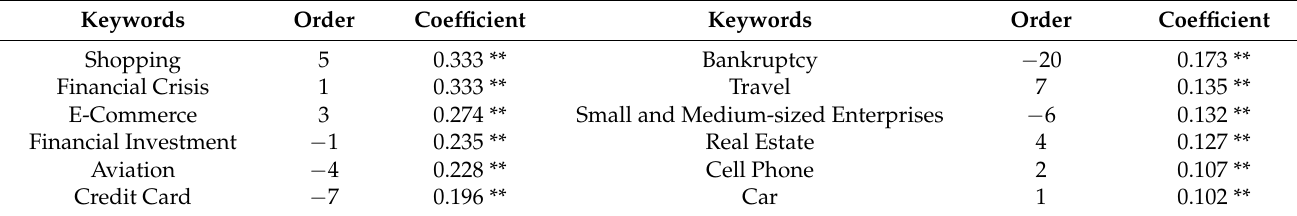
Table 13. Keywords selection based on the realized volatility (RV) correlation coefficient.